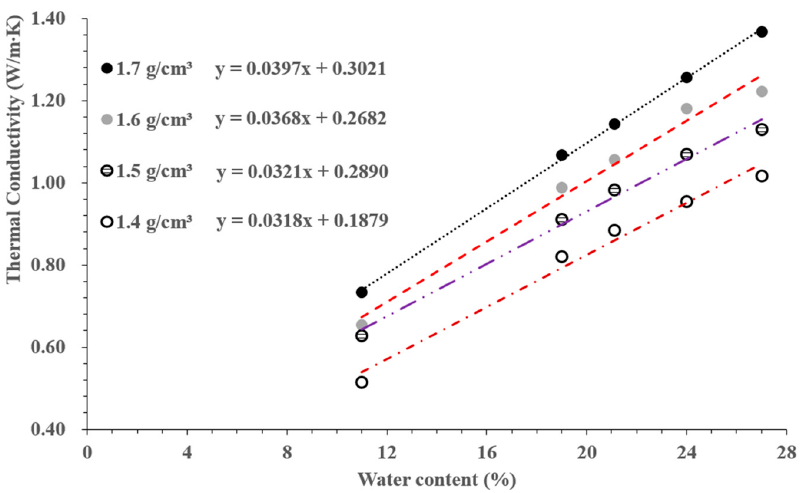
Figure 8. Comparison of thermal conductivities determined using NP and TPS methods. The thermal conductivity of SPV200 bentonite at constant dry densities with varying water contents was determined by the TPS method at room temperature (25 ◦ C). The dry density of the tested bentonite included 1.7 g/cm 3 , 1.6 g/cm 3 , 1.5 g/cm 3 , and 1.4 g/cm 3 , greater than 0.98. The thermal conductivity was observed to increase proportionally to the increase in water content at different densities. The water content is defined as the ratio with a higher thermal conductivity (0.607 W/m · K) will replace air with a lower thermal conductivity (0.024 W/m · K) in the void of the compacted bentonite. Finally, it leads to an increase of the thermal conductivity of the compacted bentonite.